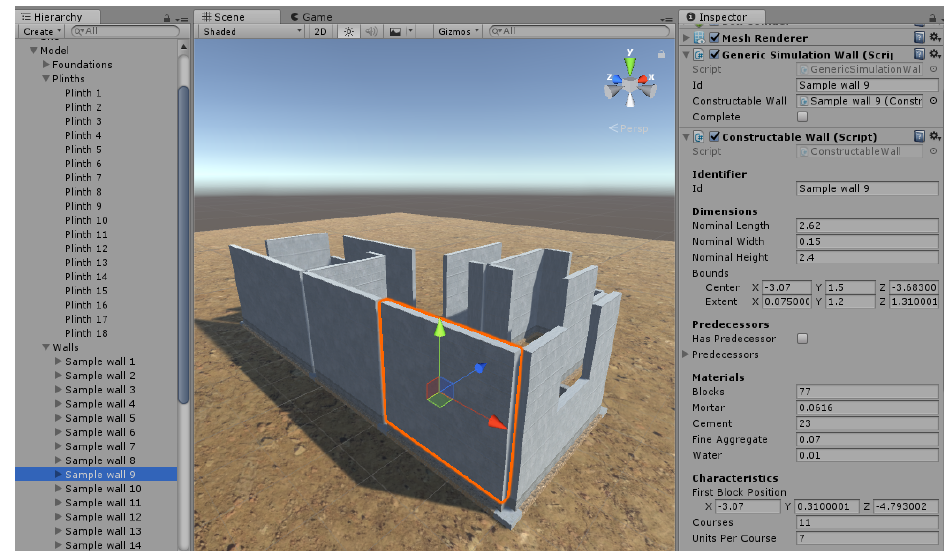
Figure 13. BIM model of masonry walls loaded into scene.